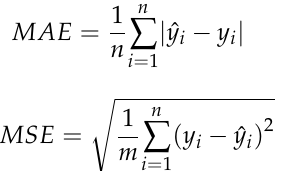
where y is the vector of observed values of the variable being predicted, and ˆ y represents the predicted